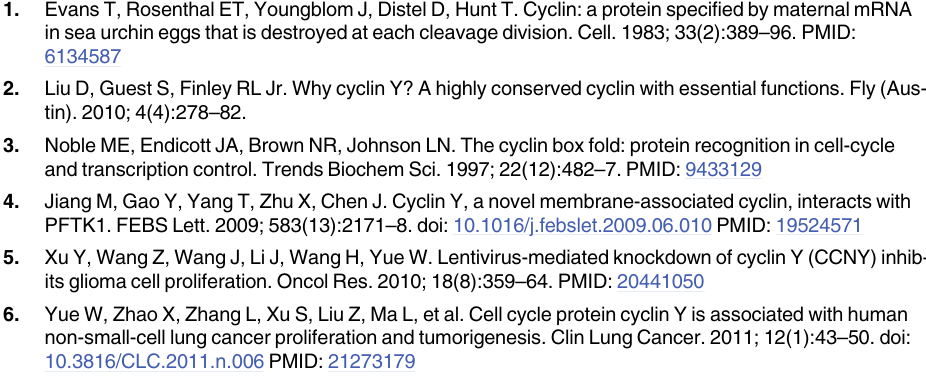
S1 Table. Examples of genes that belong to GO terms in S2 Fig. S2 Table. Examples of genes that belong to KEGG pathways in S3 Fig. (PDF) S3 Table. Oligonucleotides used for quantitative real-time